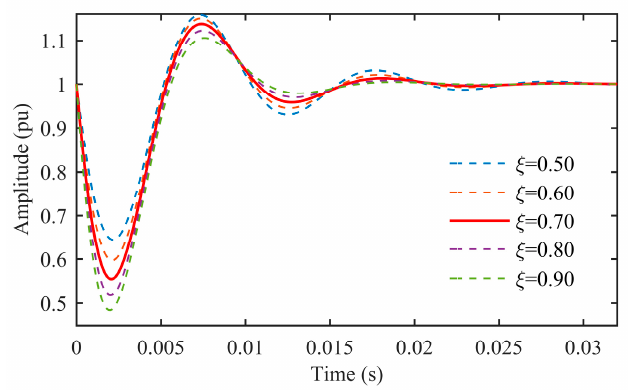
Figure 6. Step response of ANF( s ).